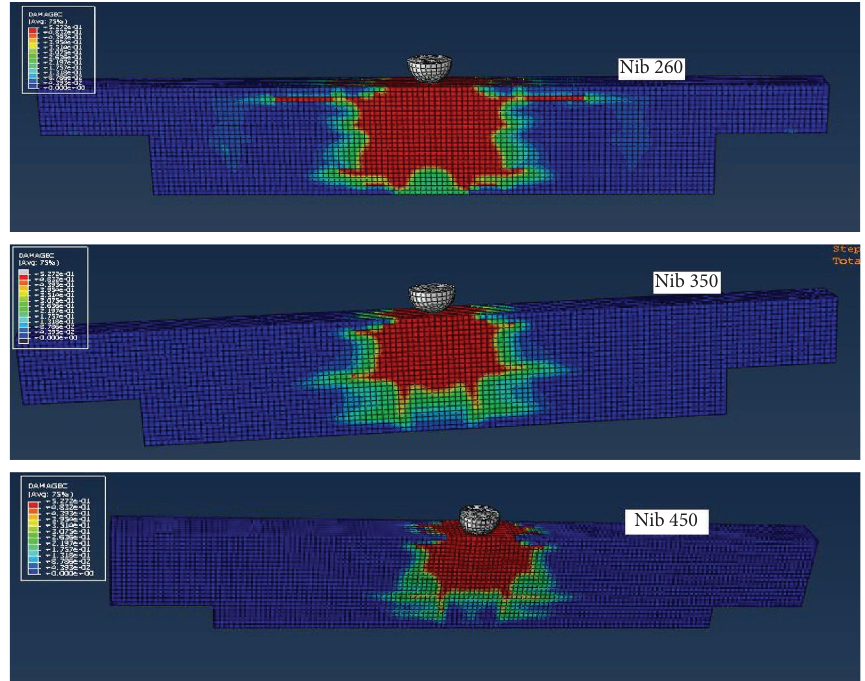
Figure 12: Damage due to nib